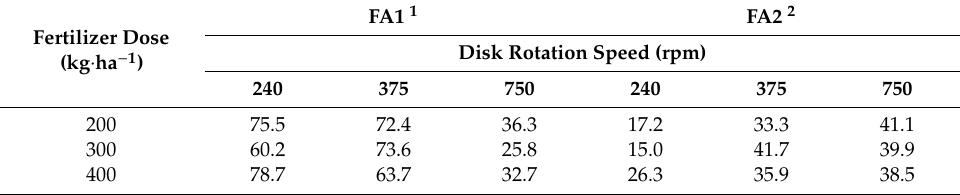
Table 3. Coe ffi cients of variation (%) of the fertilizer transverse distribution profiles for the di ff erent treatments